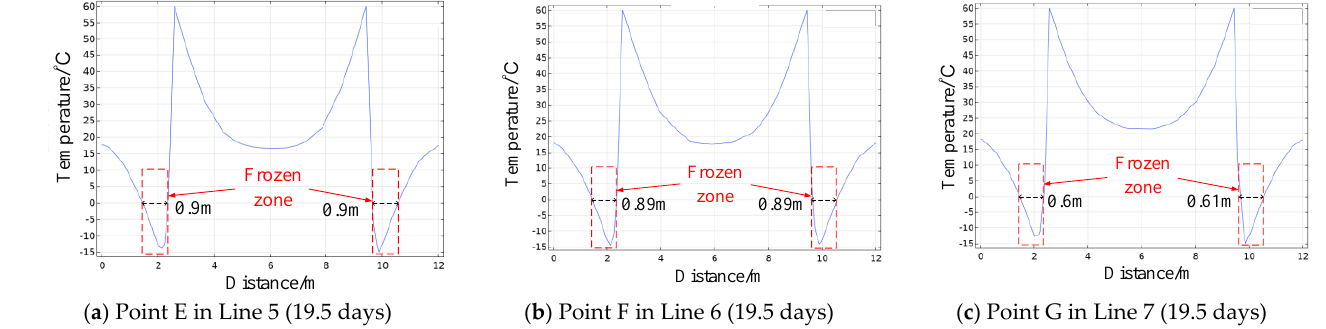
Figure 12. Temperature distribution curve of the cup-shaped frozen soil curtain.